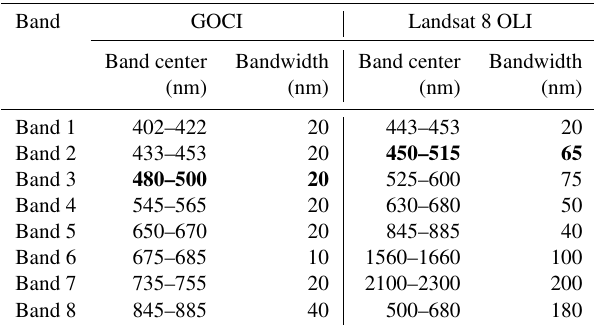
Table 1. The comparison of band range between GOCI and Landsat. The selected bands for merging Landsat and GOCI are marked in